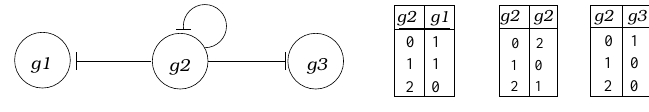
Figure 9: Multi-valued model MV with three entities g 1 , g 2 and g 3